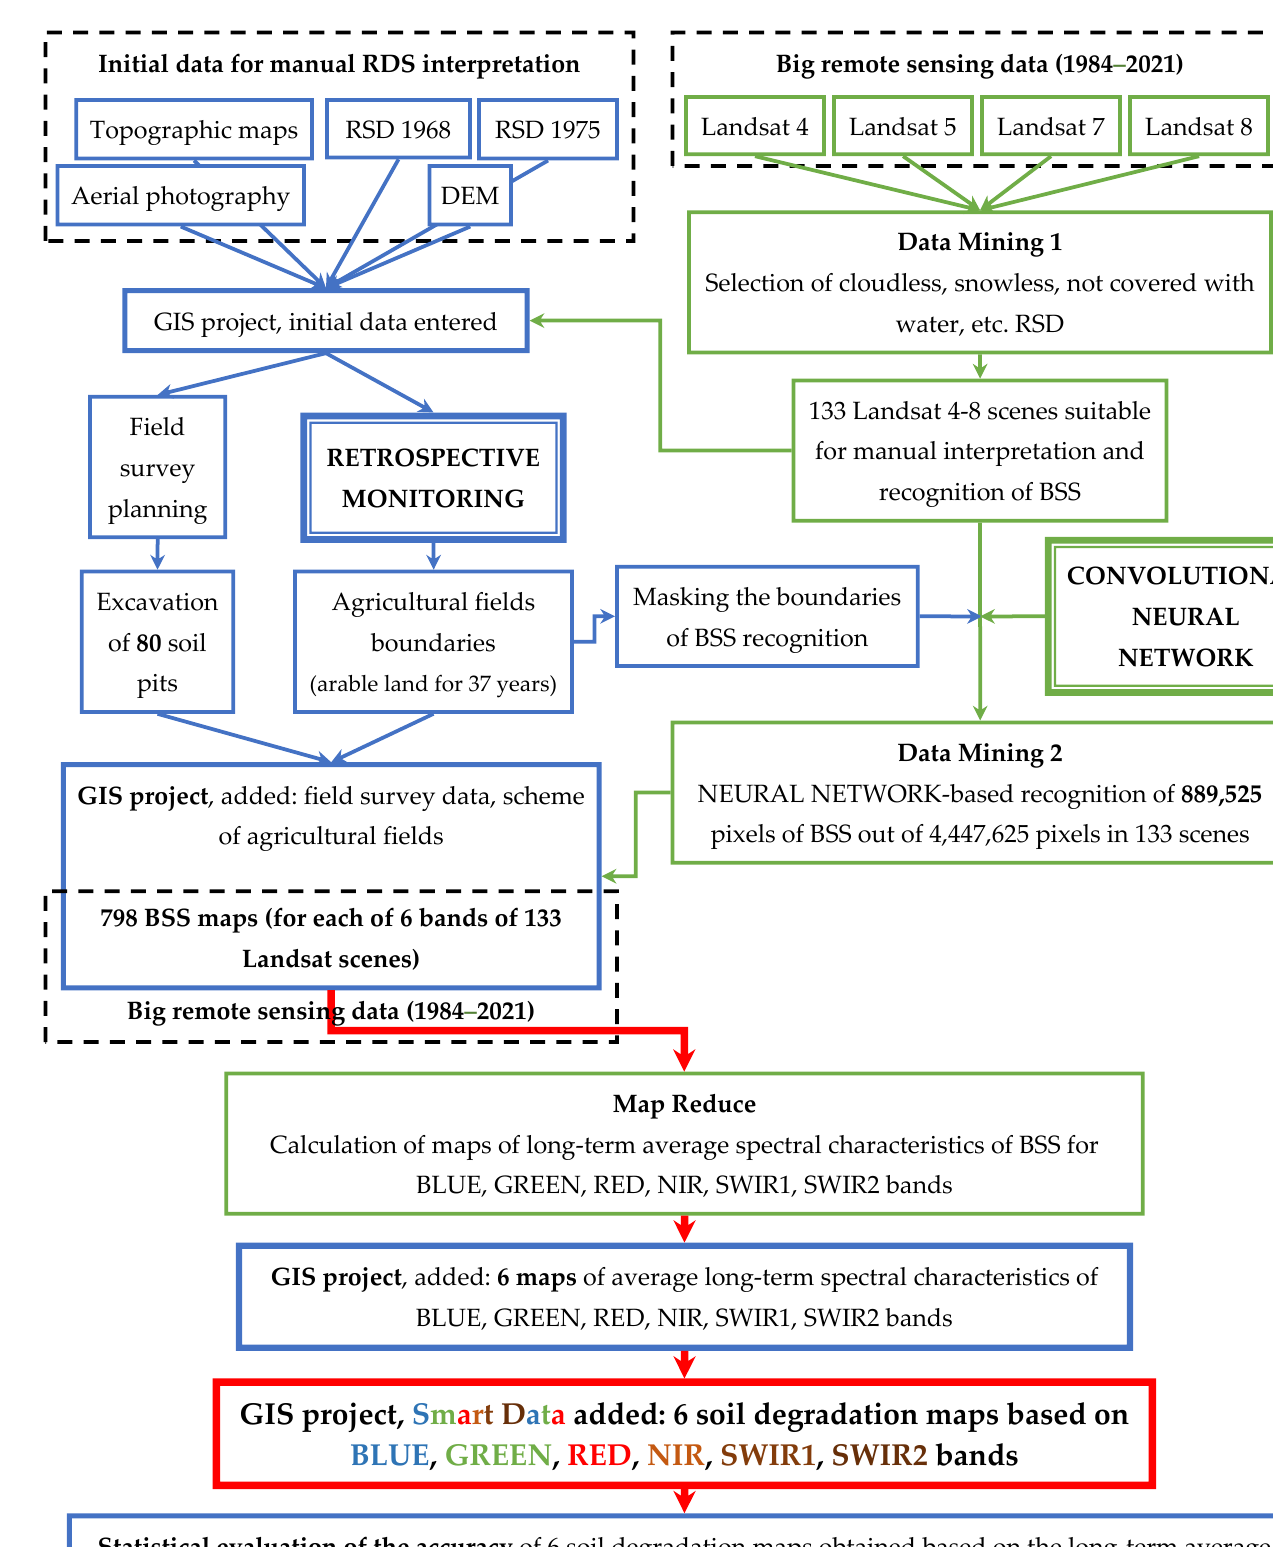
Figure 2. Research flowchart.